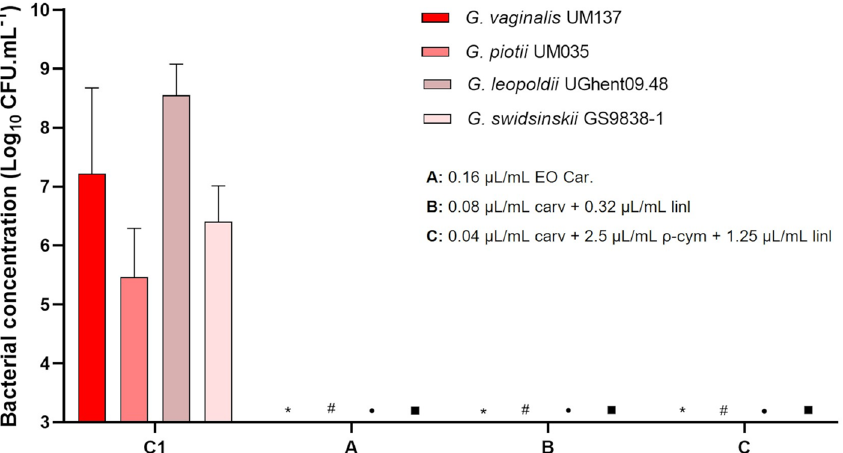
Figure 6. Analysis of biofilm cells culturability recovery of different Gardnerella species after the effect of EO Car. and specific combinations of compounds. The experiments were performed after 96 h of biofilm formation with sBHI medium. Results are represented as mean of Log (CFU.mL −1 ) with a limit of detection of Log = 3, and the error bars represent s.d. Statistical analysis was performed using a t-test (n = 4). Differences are represented when p < 0.05, when compared with control of G. vaginalis UM137 (asterisk symbol), G. piotii UM035 (hash symbol), G. leopoldii UGent 09.48 (bullet symbol) and G. swidsinskii GS 9838-1 (filled square symbol). C1: control (48 h-biofilm + 24 h sBHI + 24 h sBHI); A: 0.16 µL/mL EO Car; B: 0.08 µL/mL carv + 0.32 µL/mL linl;